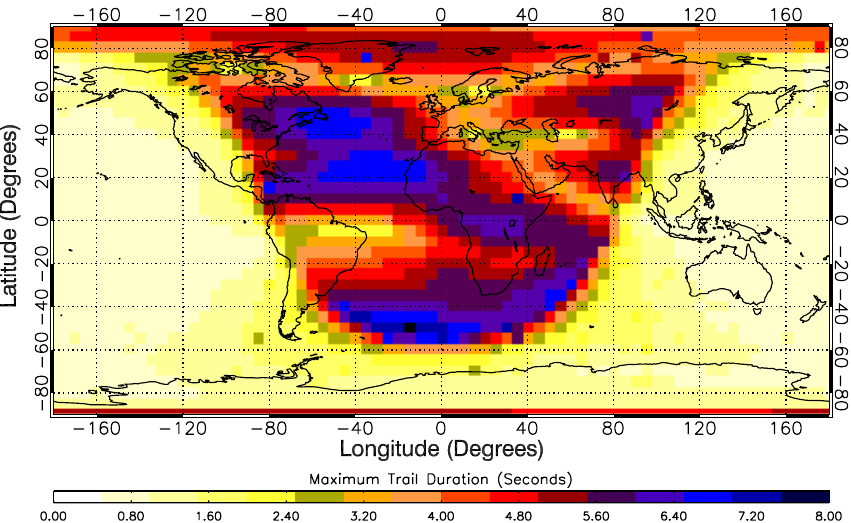
Fig. 4. A global simulation of the duration of meteor trail turbulence of a single 1µg meteor simulated globally with 5 ◦ grid points, traveling at 35kms − 1 with an entry angle of 45 ◦ at 00:00UT on 1 January. The units of the color bar are in seconds after meteor trail creation. Each pixel results from the measured duration of a simulation of the type shown in Fig. 1. This 35kms − 1 case provides an interesting comparison with Fig. 2b, which has a speed of 55kms − 1 . This simulated meteor traveling at 35kms − 1 has a preferred velocity for producing a long duration meteor trail. Not only are longer duration trails produced, but there are also trails in areas where they were absent or short lived in Fig. 2b.